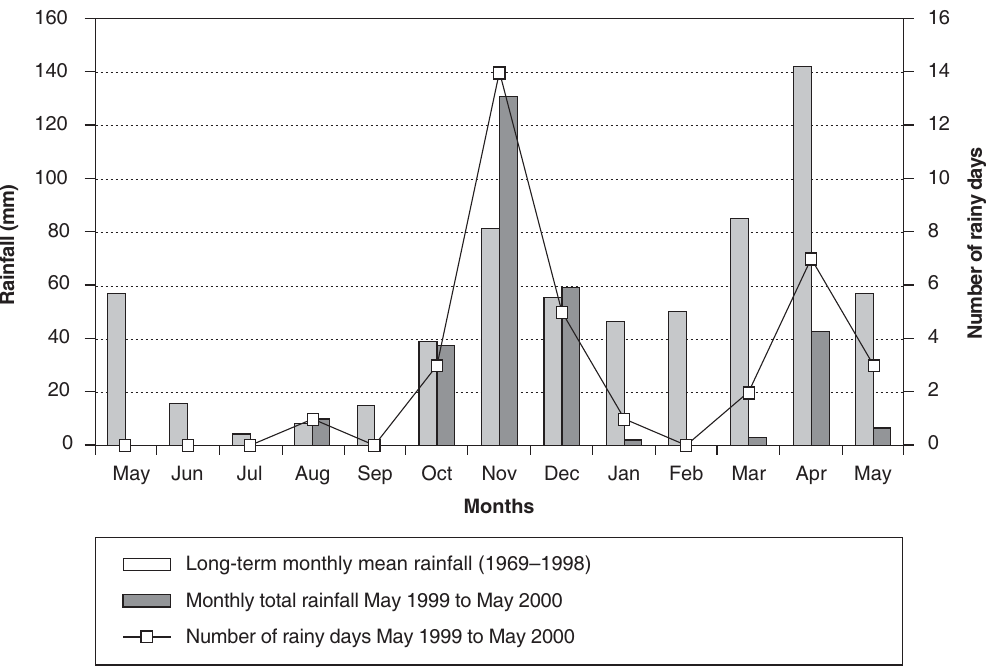
Long-term monthly rainfall (1969–1998), the total monthly rainfall and the number of rainy days per month (May 1999 to May 2000) for Isinya Division in Kajiado district